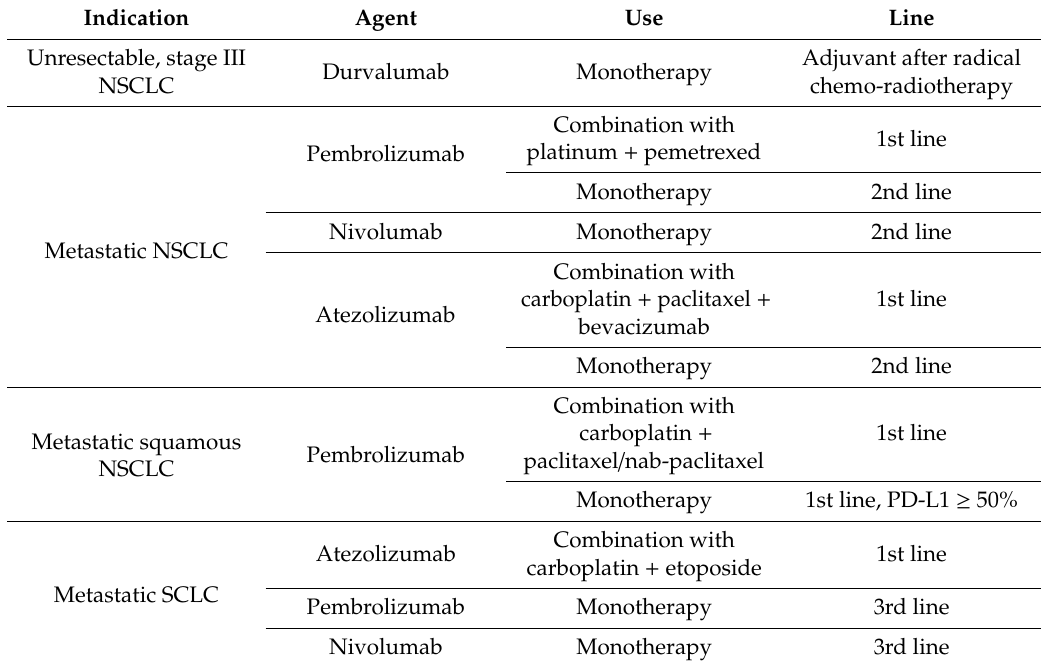
Table 1. Current FDA-approved indications for lung cancer